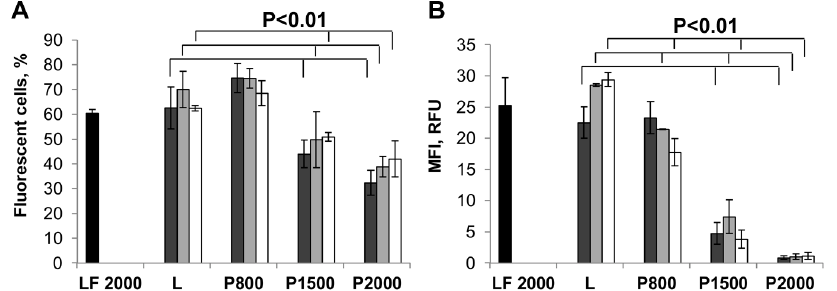
Figure 3. Liposomes-mediated delivery of plasmid DNA in HEK 293 cells measured by EGFP expression. The percentage of EGFP-positive cells ( A ) and mean fluorescence intensity (MFI) of the cell population ( B ) were evaluated by flow cytometry 48 h after transfection. Cells were incubated with the lipoplexes formed by liposomes and pEGFP-C2 (2 μ g/mL) at N/P ratios of 4/1 (dark grey bars), 6/1 (light grey bars) or 8/1 (white bars) in the presence of 10% FBS. LF2000 - Lipofectamine 2000 (black bars) was used under optimal conditions. The differences between mean values for L and other preparations at the same N/P with p < 0.01 were considered statistically significant according to Mann-Whitney U-test.